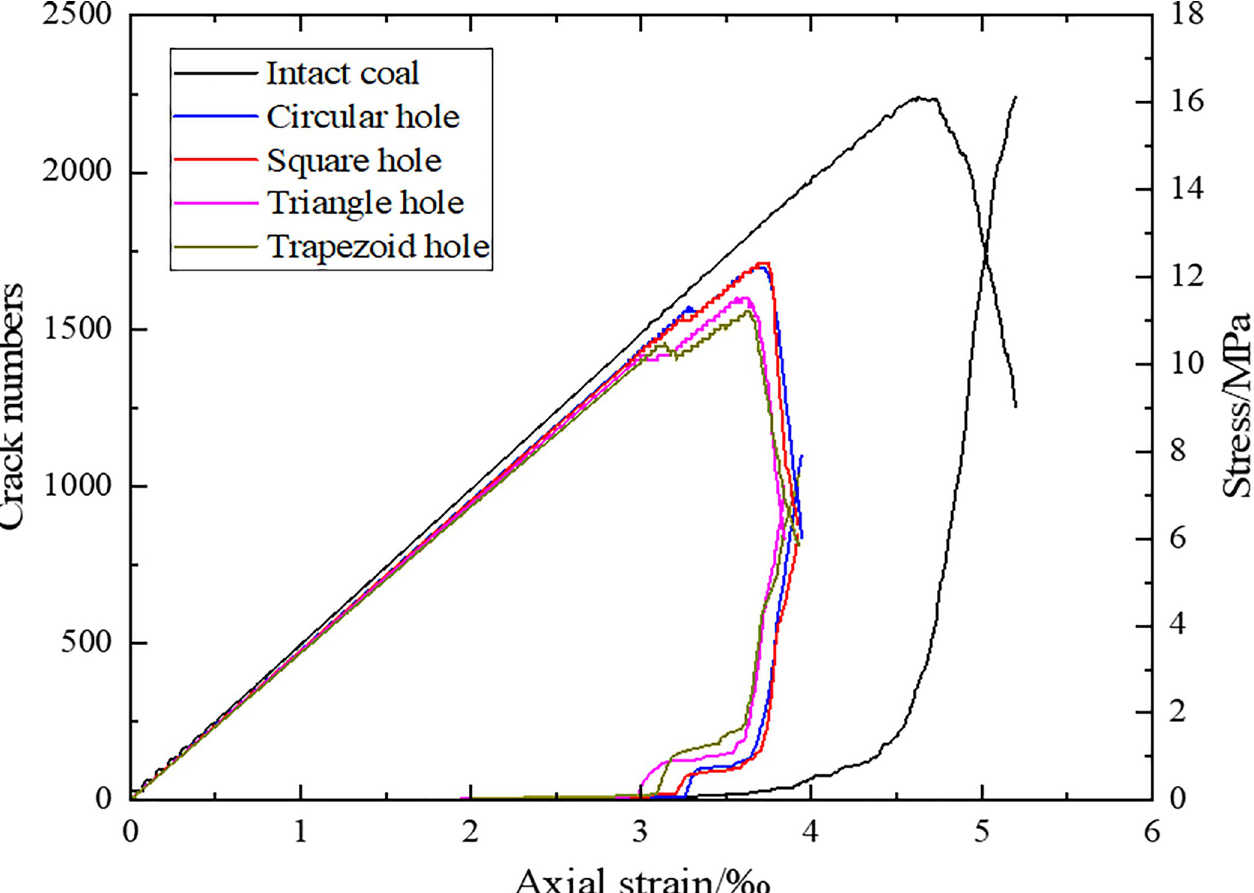
Fig 6. Relationship between stress, crack number and axial strain of coal and rocks with hole defects of different shapes.